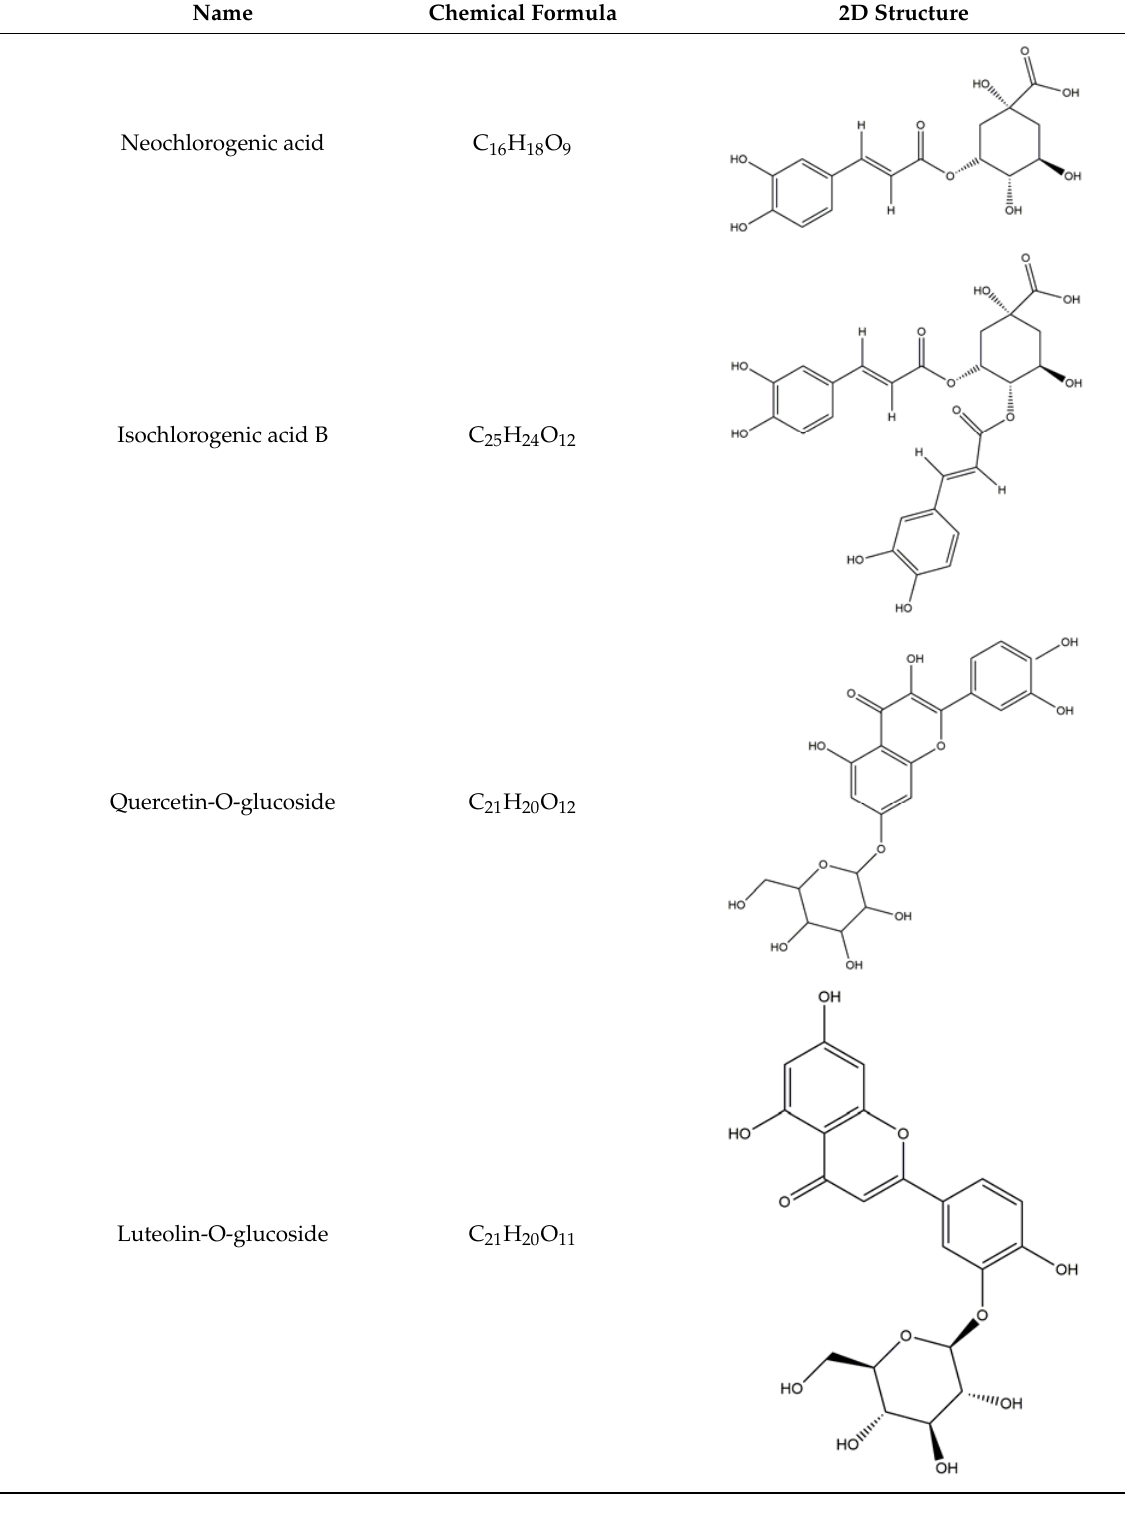
Table 1. Main active ingredients from LJF.